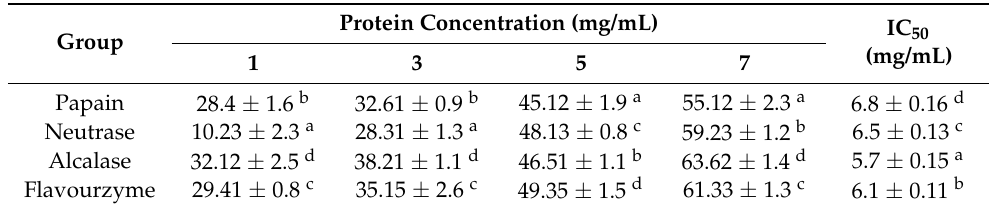
Table 1. ACE-inhibitory activity of